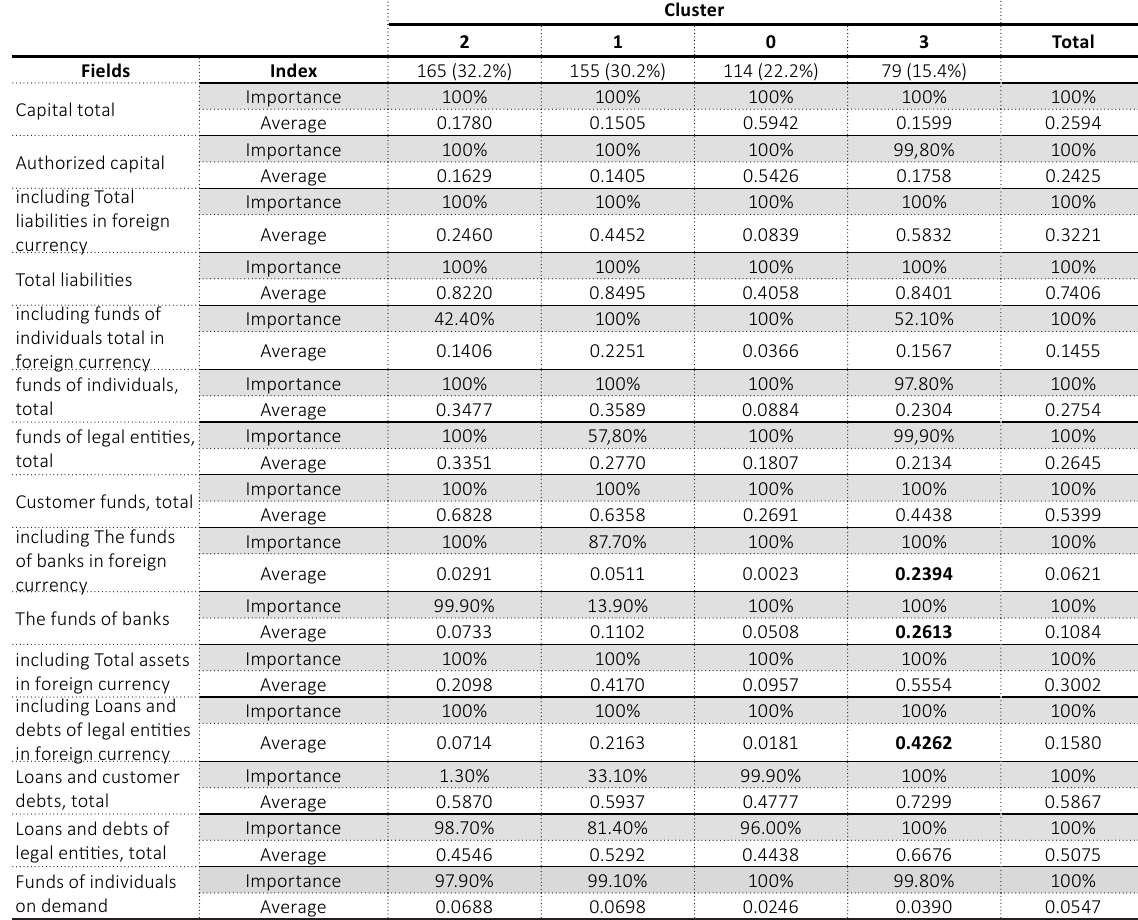
Source: Developed by the